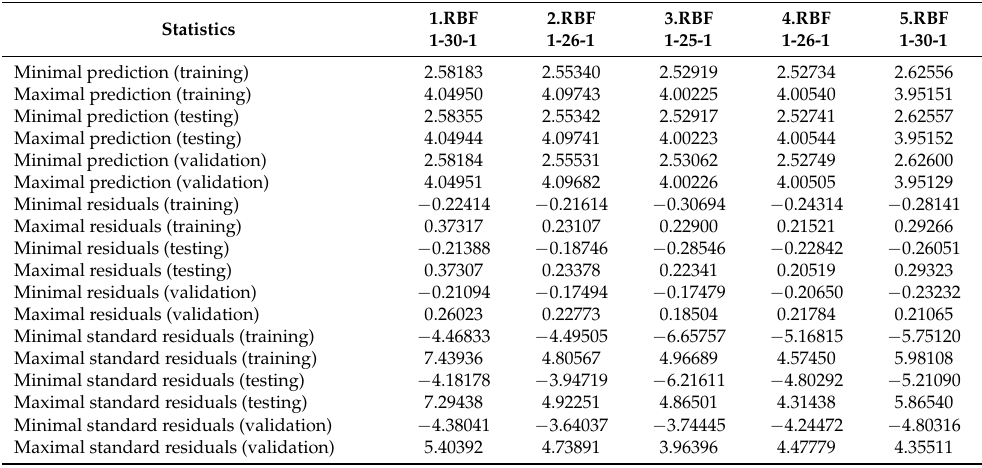
Table 3. Statistical characteristics of the individual datasets according to the retained neural network.